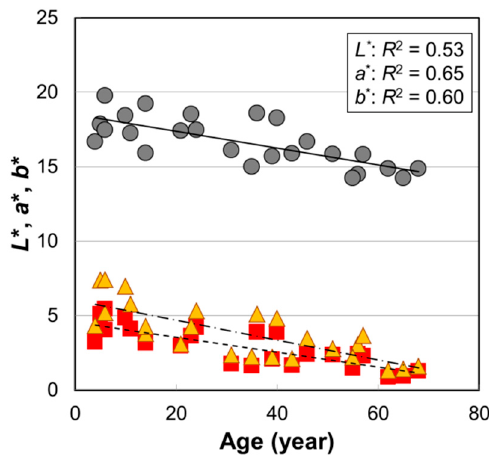
Figure 1. The age dependences of hair color parameters L * , a * , and b * values of Japanese female hair bundles. Circles, L * ; squares, a * ; triangles, b * . Lines are the fitted curves. Solid line, L * ; dashed line, a * ; dot-and-dash line, b * . p = 3.3 × 10 − 5 ( L * ), 1.1 × 10 − 6 ( a * ), and 5.6 × 10 − 6 ( b * ). Table 1. p -values by the regression analysis between hair color parameters and various values. Hair Color Parameter Human